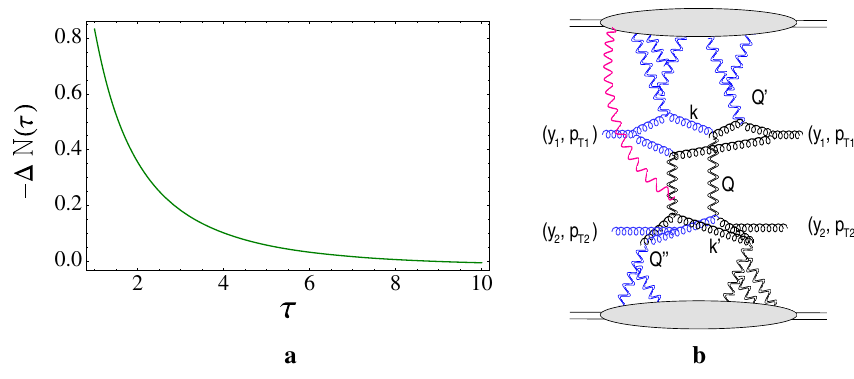
τ d N (τ) d τ d τ